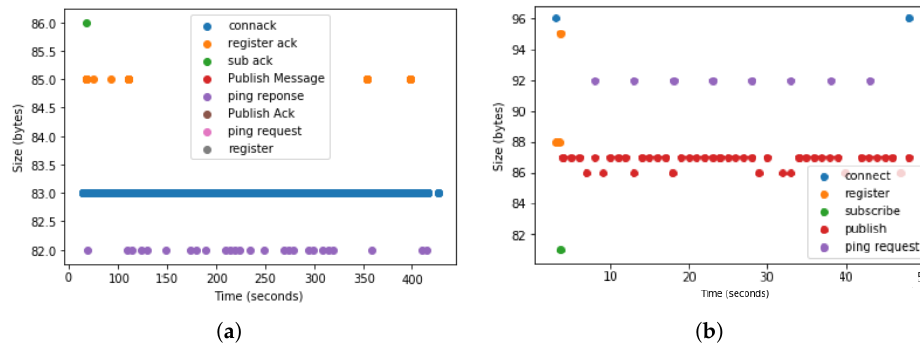
Figure 12. Disconnect wave attack evaluation diagrams. ( a ) MQTT-SN broker after disconnect wave attack. ( b ) MQTT-SN legitimate client after the disconnect wave attack.